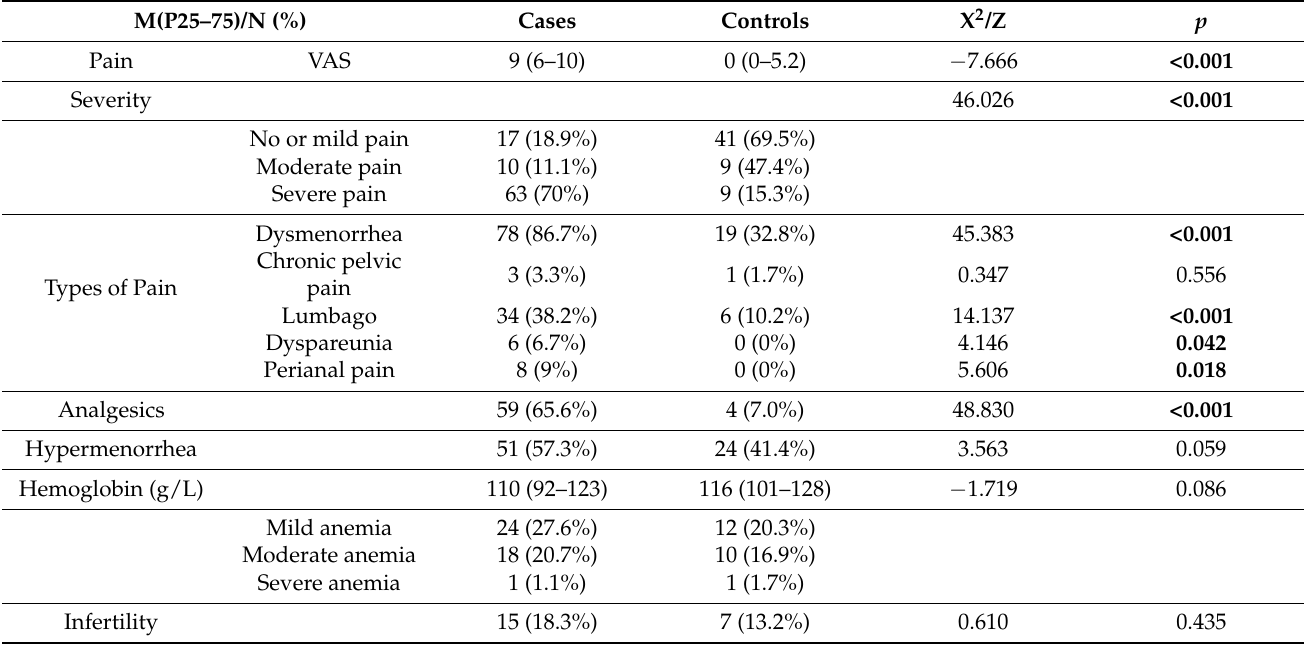
Table 2. Clinical symptoms.